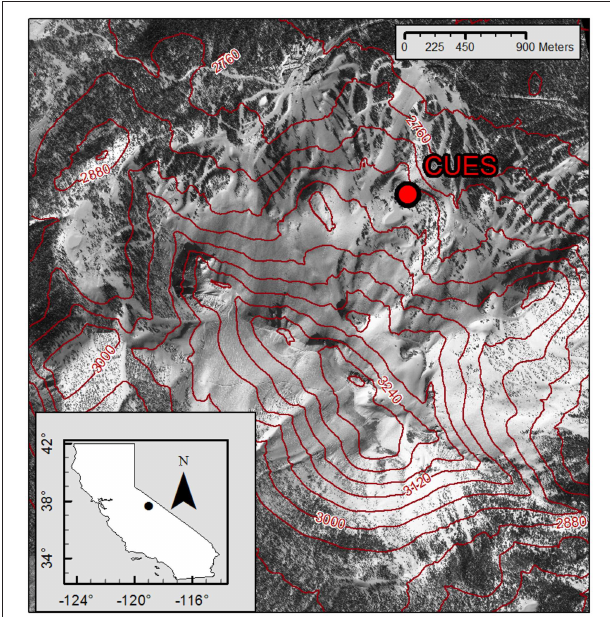
FIGURE 1 | CUES and Mammoth Mountain, CA USA. Elevation contours are drawn in red, the interval is